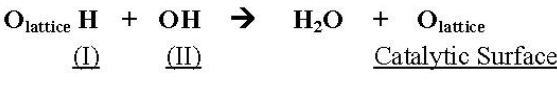
Figure 6. Chain reaction from the catalytic reaction between cellulose and